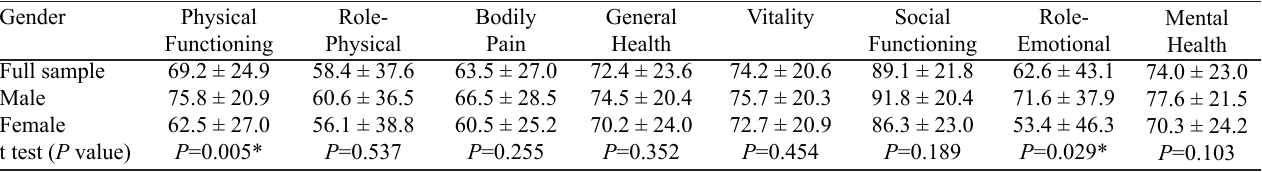
Table 3. Mean values for quality of life from the SF-36 questionnaire for full sample and comparison of domains according to gender (t test). Gender Full sample Male Female t test ( P